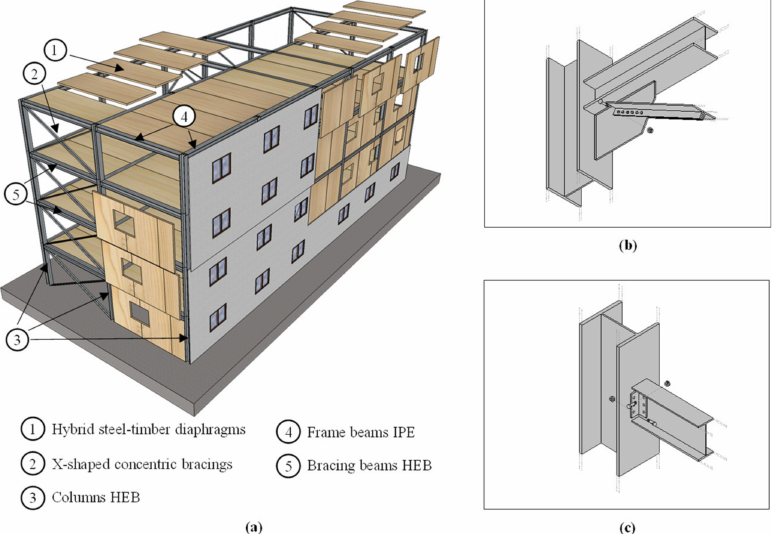
Figure 2. Building construction model ( a ); Bracing joints ( b ); Beam-to-column joints ( c ).